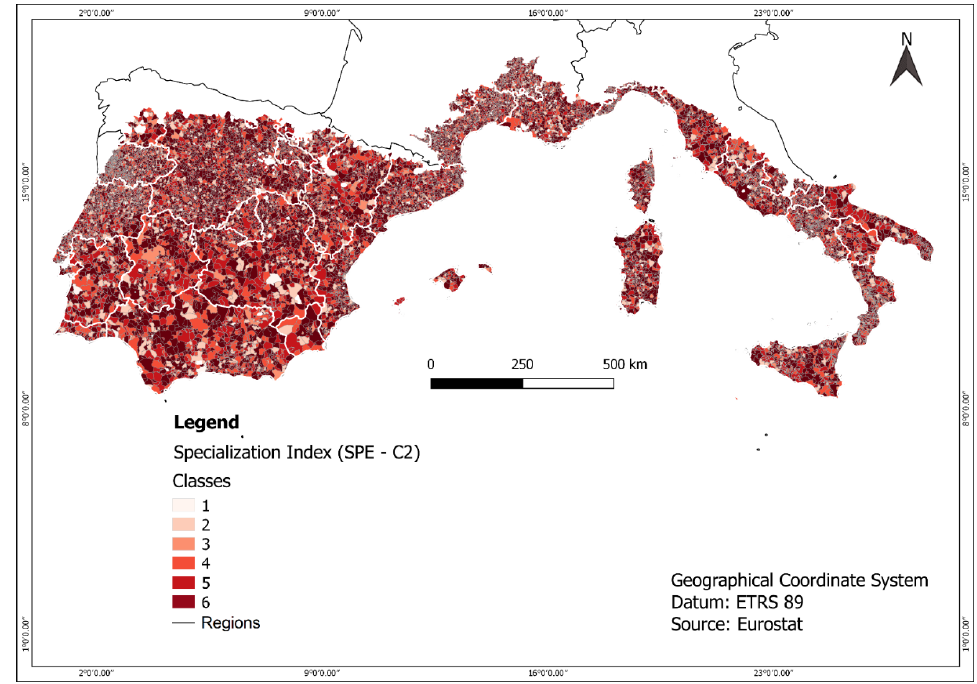
Figure 12. Map of spatial distribution of LAUs among the five intensity classes of SPE for the 2nd census date (C2).